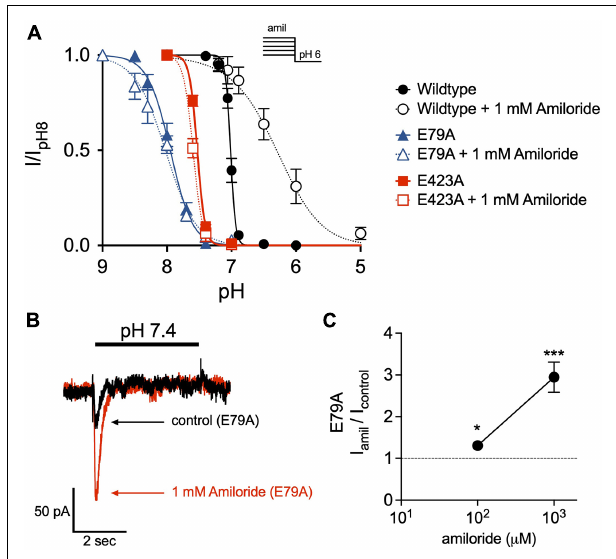
FIGURE 8 | The non-proton ligand-sensing domain is required for the amiloride-induced acidic shift in steady-state desensitization. (A) pH dose-response curves for steady-state desensitization (SSD) in ASIC3 wildtype, E79A, and E423A under control conditions (no amiloride) and with the 1 mM amiloride concentration solution normalized to the currents evoked by stepping from pH 8 to pH 6 ( n = 4–8 for each point). Lines are fits of the Hill equation (pH 50 = 7.01, 7.95, and 7.53 under control conditions for wildtype, E79A, E423A, respectively; with 1 mM amiloride pH 50 = 6.31, 8.02, and 7.59) (B) Representative superimposed E79A pH 7.4-evoked currents in the absence and presence of 1 mM amiloride. (C) Dose-response effect of amiloride 0.1 and 1 mM on pH 7.4-evoked currents in ASIC3 E79A ( n = 8; * p = 0.02 0.1 mM vs. control; *** p < 0.001 1 mM vs. control, one-way